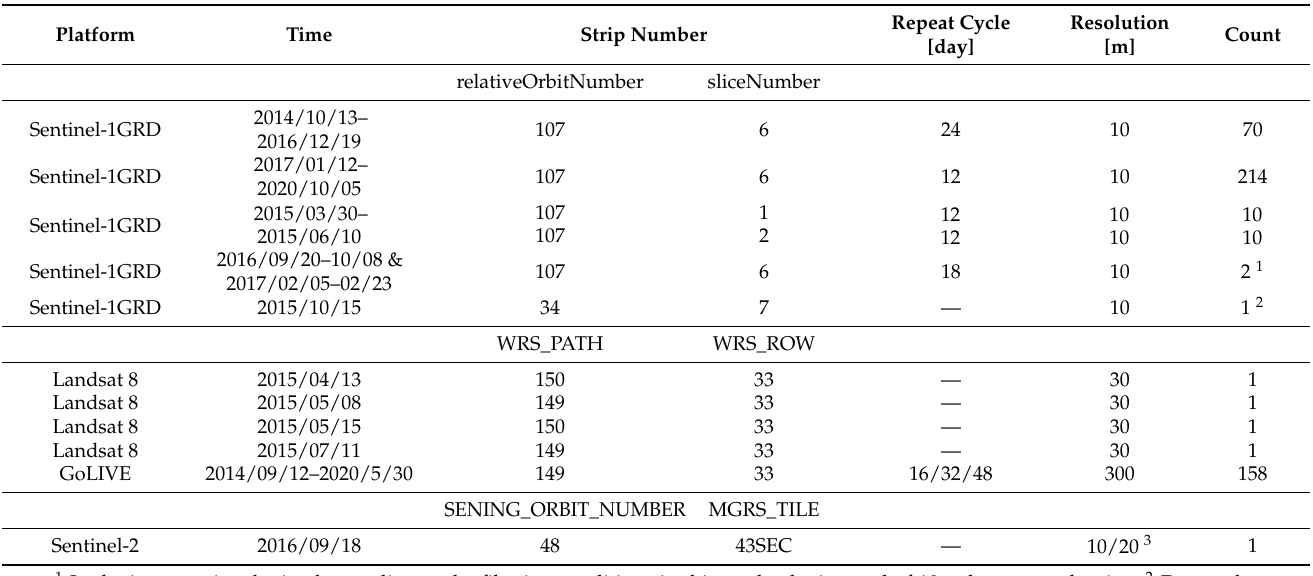
Table 1. The information of data used in this study. Due to the different satellite-based on different satellite orbit coordinate system, we ascertain the location of Sentinel-1 ground range-detected (GRD), Landsat 8 and Sentinel-2 images by” relativeOr- bitNumber and sliceNumber”,” WRS_PATH & WRS_ROW” and “SENING_ORBIT_NUMBER & MGRS_TILE” respectively. Repeat Cycle Platform Time Strip Number